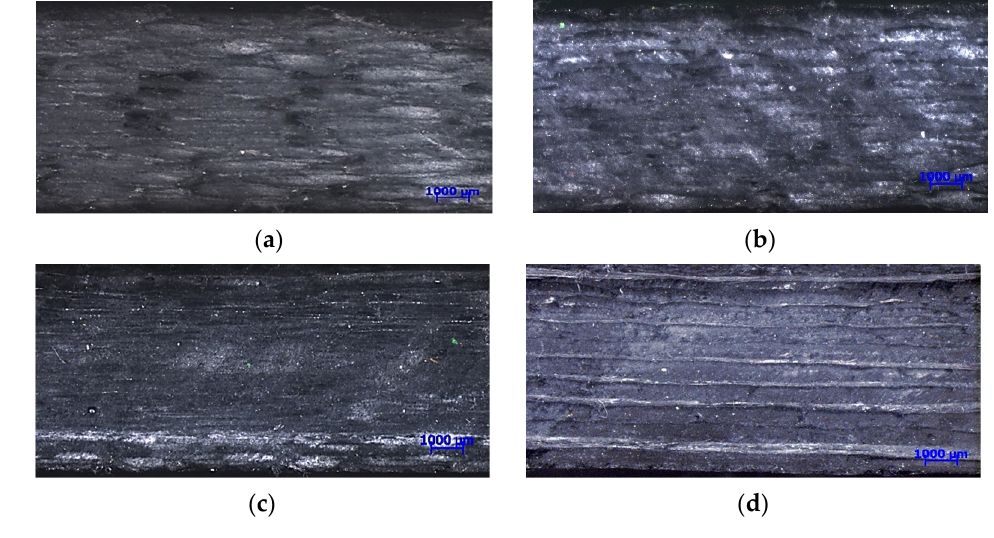
Figure 2. Microscopic images of S1 ( a ), S2 ( b ), S3 ( c ) and S4 ( d )